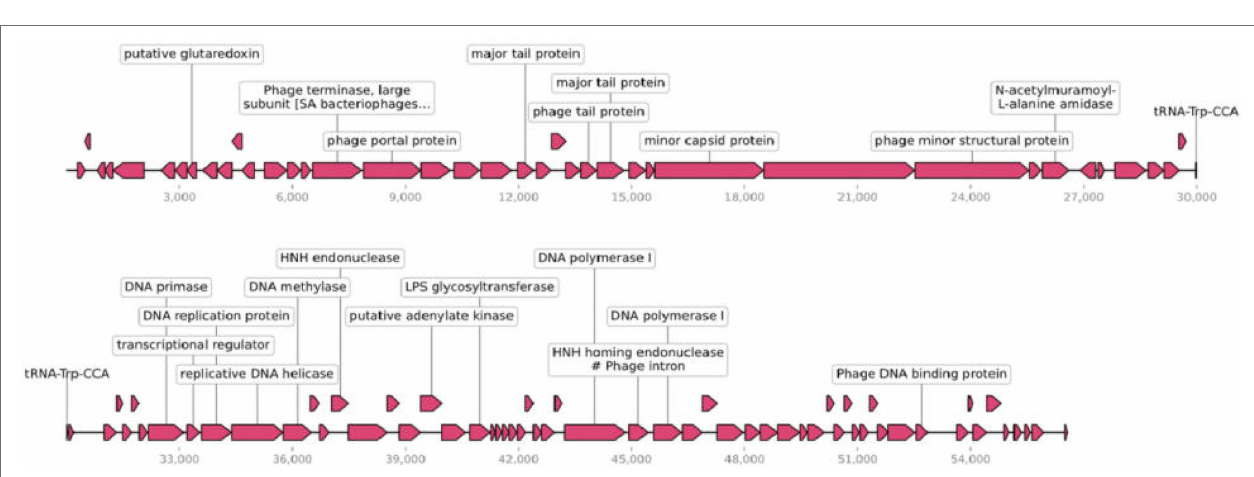
FIGURE 3 | Genomic characterization of efap05-1. Phage efap05-1 is a dsDNA phage that encodes 99 predicted proteins and one tRNA.